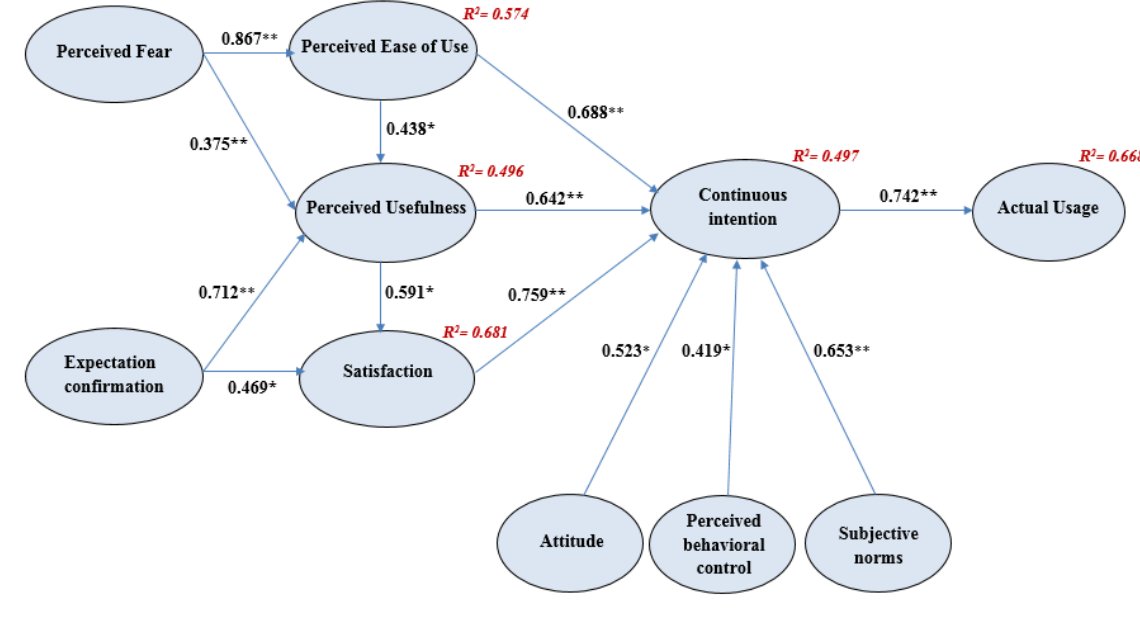
Fig. 3. Hypotheses testing